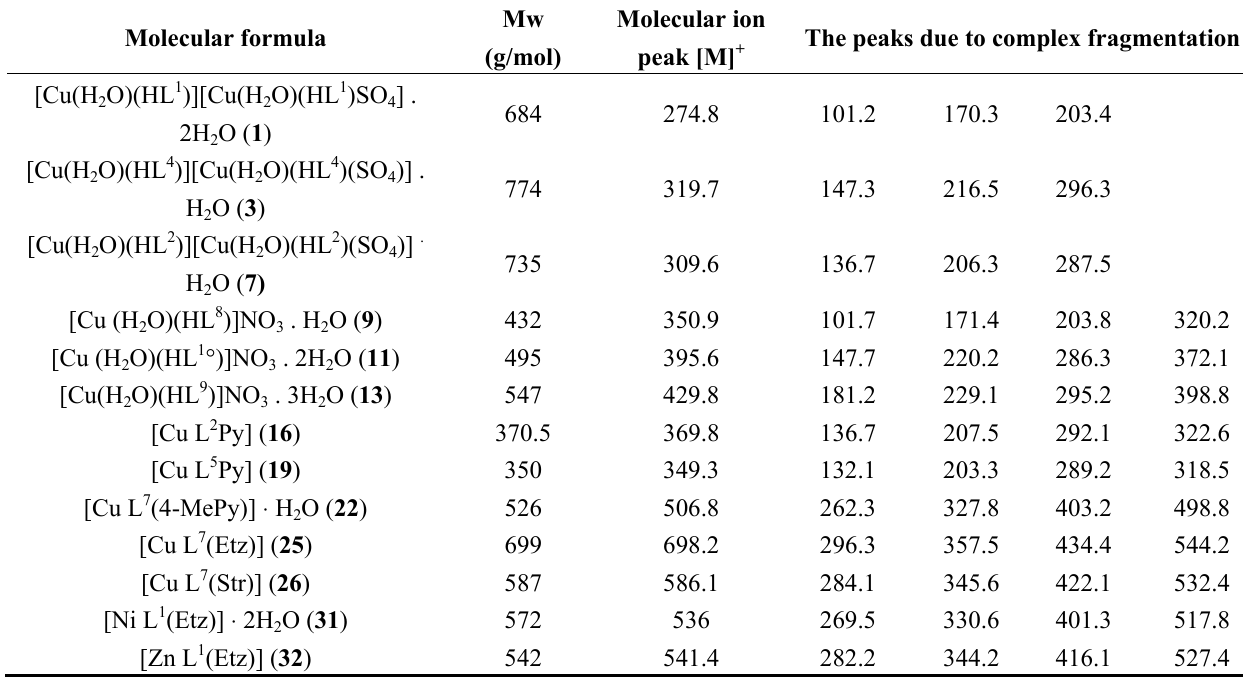
Table 2. FAB mass spectral data of Cu(II) Ni(II) and Zn(II)